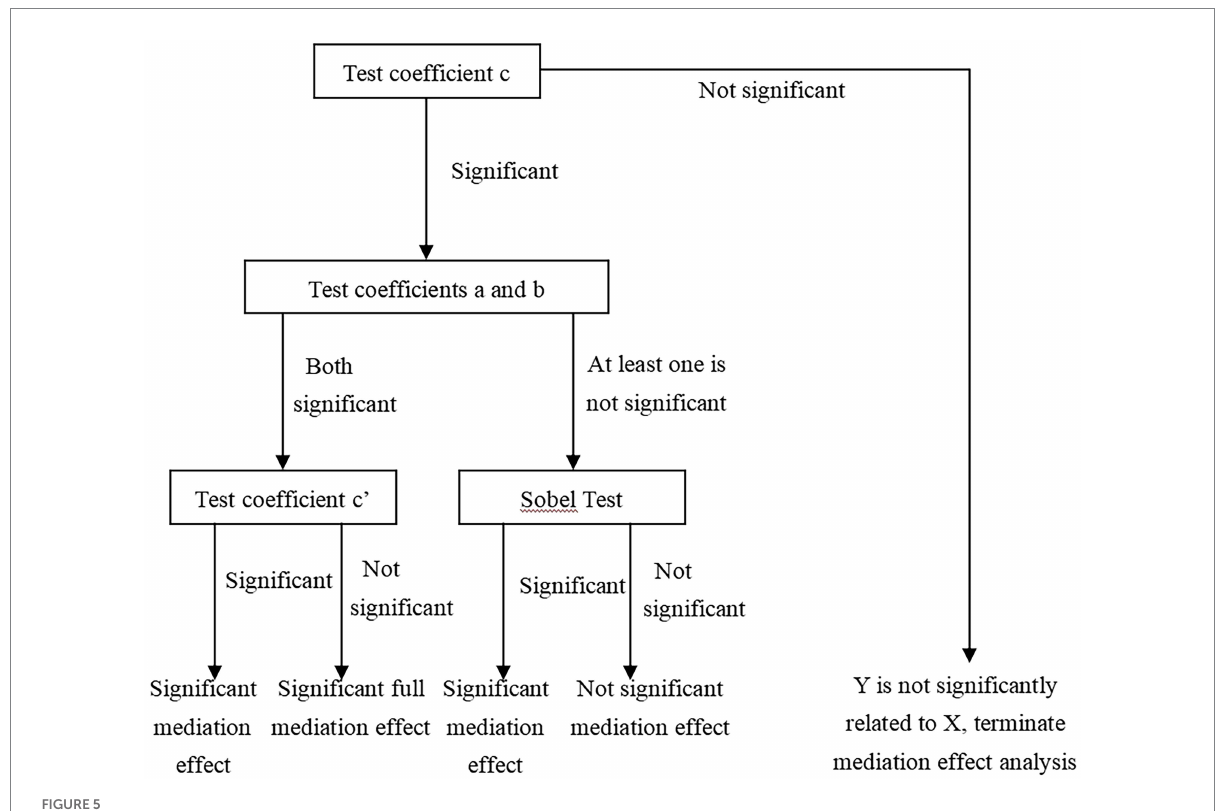
FIGURE 5 Mediation effect test